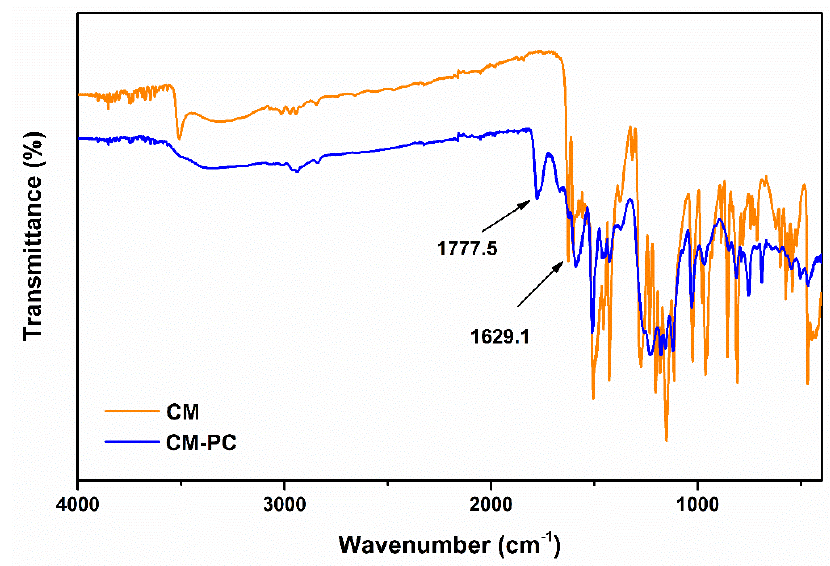
Figure 8. IR spectra of CM and CM-PC polymer.